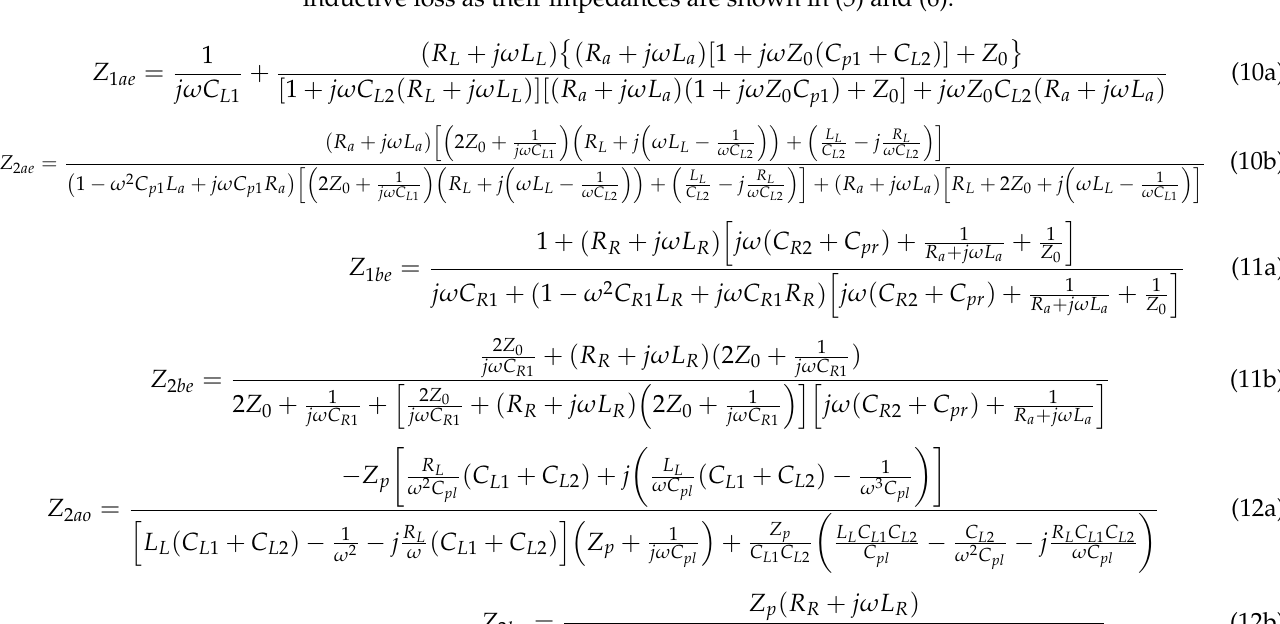
Figure 9. The odd-mode circuits of balun with common inductor between ( a ) Port 1 and Port 2 and